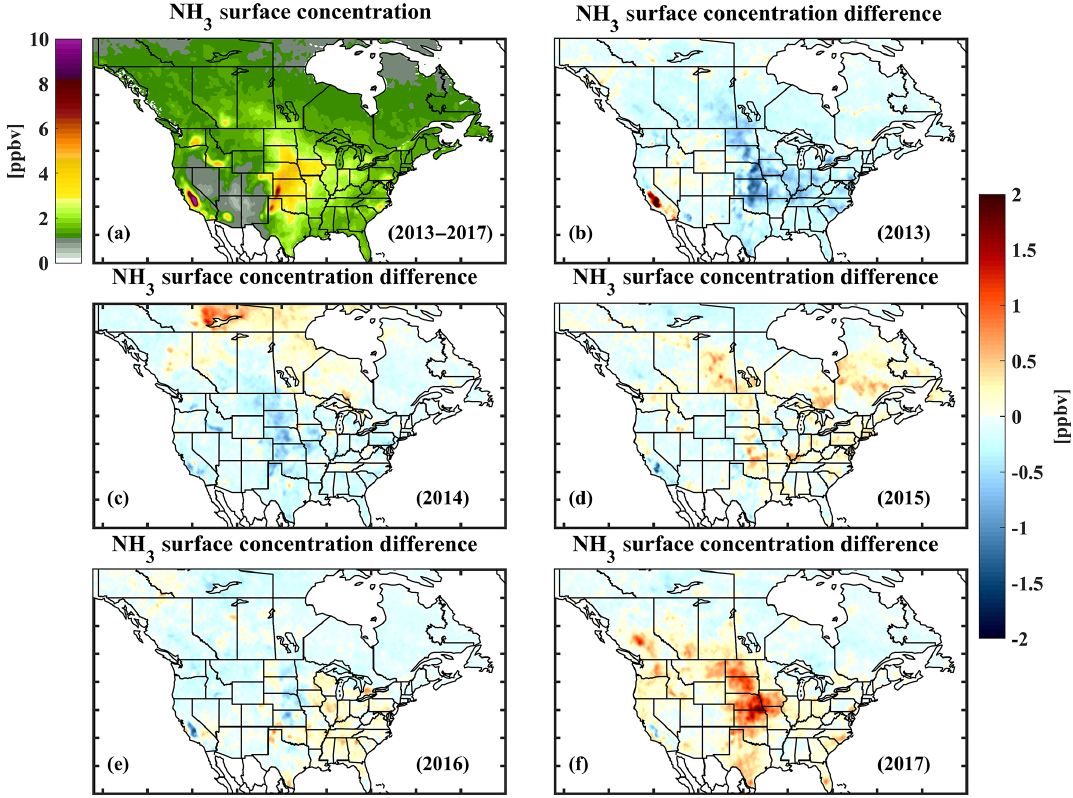
Figure 11. Plots of the CrIS-retrieved surface volume mixing ratio concentrations of ammonia. Plot (a) is the 5-year annual average values of the concentrations from 2013 to 2017. Plots (b) to (f) are annual differences from the 5-year mean for each year from 2013 to